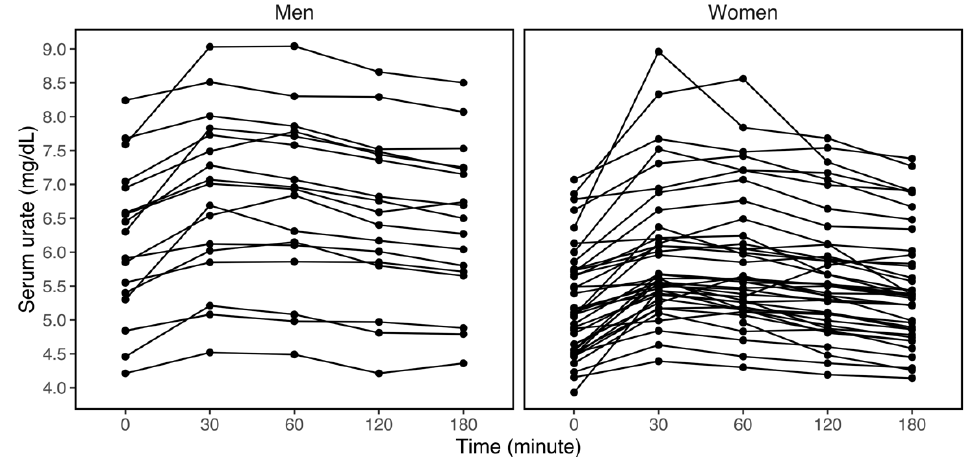
Figure 2. Individual trajectories of serum urate (mg/dL) within three hours after the fructose challenge, stratifying by sex (N men = 17, N women = 40). Each line represents one participant. For most participants, serum urate increased drastically in the first 30 min and then gradually declined towards baseline levels in the remaining 150 min. On average, men had higher serum urate concentrations throughout the three hours.